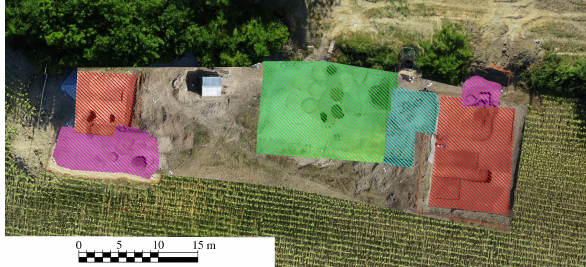
Figure 5: Survey areas by year: 2011-Green; 2013-Cyan; 2014- Red;